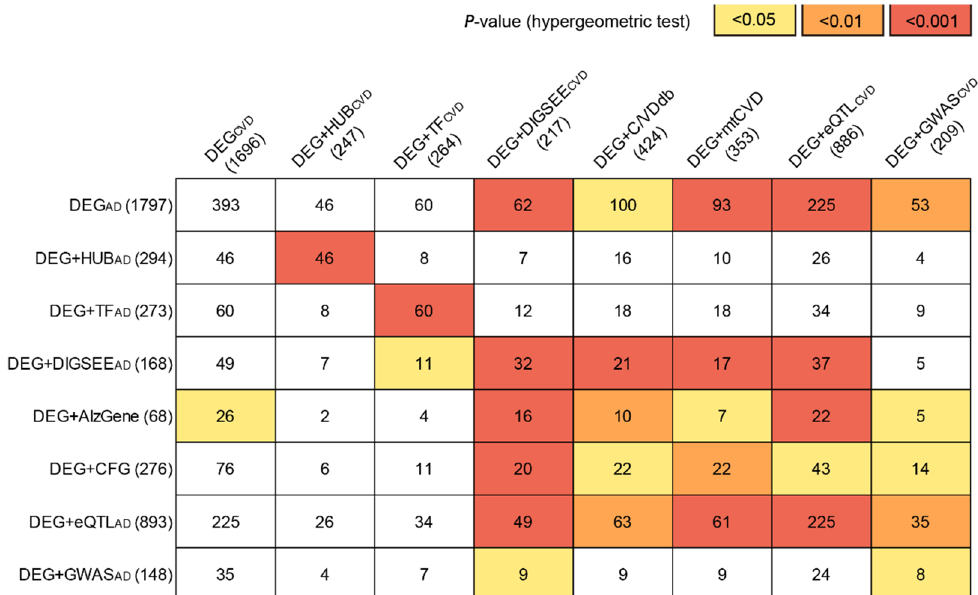
Figure 3. The blood AD- and CVD-related genes. The numbers in parentheses indicate the number of selected candidate DRGs. Numbers in the matrix are the number of common genes between each of the eight-sets of the blood AD- (row) and CVD-related genes (column). DRGs, disease-related genes; AD, Alzheimer’s disease; CVD, cardiovascular disease; DEG, differentially expressed gene; TF, transcription factor; CFG, convergent functional genomics; eQTL, expression quantitative trait loci; GWAS, genome-wide association study; mtCVD, multi-tissue CVD-related genes.